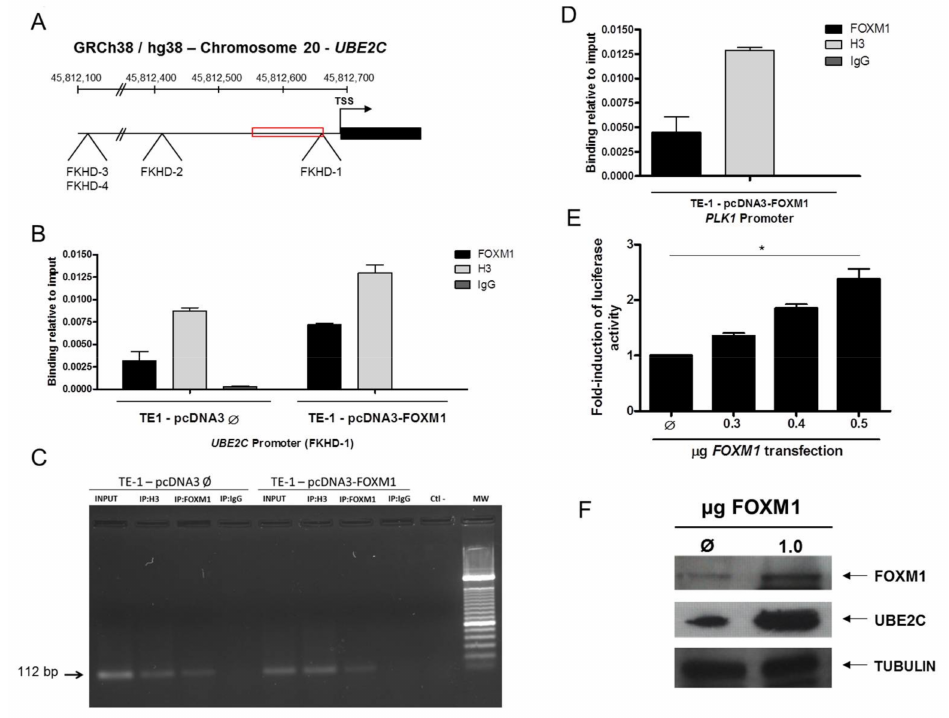
Figure 5. FOXM1 transcriptionally activates UBE2C in the ESCC cell line TE-1. ( A ) Schematic representation of the FOXM1 putative response elements position in the 5 (cid:48) regulatory region of UBE2C . Black arrow represents the transcriptional start site (TSS) of UBE2C. The putative response elements described are located about − 31, − 290 and − 590 bases upstream of the transcription initiation site and the red frame shows the region encompassed by the primers used to amplify UBE2C promoter following FOXM1 immunoprecipitation in TE-1 cell line; ( B ) ChIP assay in the ESCC cell line TE-1 transfect both with FOXM1 induction expression vector (pcDNA3-FOXM1) and empty vector (pcDNA3). Cross-linked chromatin was immunoprecipitated with anti-FOXM1 antibody (IP:FOXM1) or with anti-histone H3 antibody (IP:Histone H3), used as a positive control, or with anti-normal rabbit IgG antibody (IP:IgG), used as a negative control. Following FOXM1 immunoprecipitation, purified DNA was analyzed by qPCR, using specific primers for − 31 to − 153 bases of UBE2C promoter region encompassing FOXM1 putative response element (FKHD-1). The amount of immunoprecipitated DNA in each sample is represented as a signal relative to the total amount of input DNA. Values are shown as triplicate of the qPCR experiment ± SD; ( C ) In addition, a representative gel image of ChIP results is presented. Ctrl-: PCR negative control; MW—molecular weight (lower marker 100 bases pairs); Black arrow indicates the expected amplified fragment (112 base pairs); ( D ) FOXM1 binding onto PLK1 promoter was used as positive binding control. The amount of immunoprecipitated DNA in each sample is represented as a signal relative to the total amount of input DNA. Values are shown as triplicate of the qPCR experiment ± SD ( E ) TE-1 cells were co-transfected with UBE2C -luciferase reporter (comprising FKHD1 and FKHD2) and increasing amounts of either FOXM1 expression vector (pcDNA3—FOXM1) or the control (empty) vector pcDNA3 (Ø) and the luciferase assay was performed; ( F ) The ESCC cell line TE-1 was transfected with 1.0 µ g of DNA of a FOXM1 expression vector (pcDNA3—FOXM1) or with an empty vector (pCDNA3-empty), used as control (Ø) and, then, FOXM1 and UBE2C protein levels were analyzed by Western blotting, using tubulin as loading control. The dotted lines delineated the bands selected from the western blotting analysis, according to the molecular weight of the protein investigated. * p value <